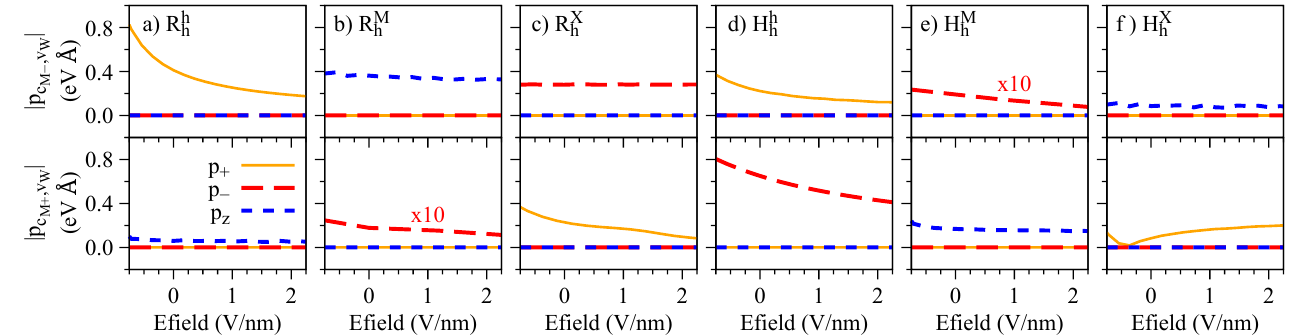
Figure 12. Absolute value of the dipole matrix element for interlayer transitions at the K point as a function of the electric field for ( a ) R h Based on the calculated values of the energy dependence and dipole matrix elements, with respect to the electric field, we can evaluate the radiative lifetime for direct dipolar excitons, given by [122,123]: